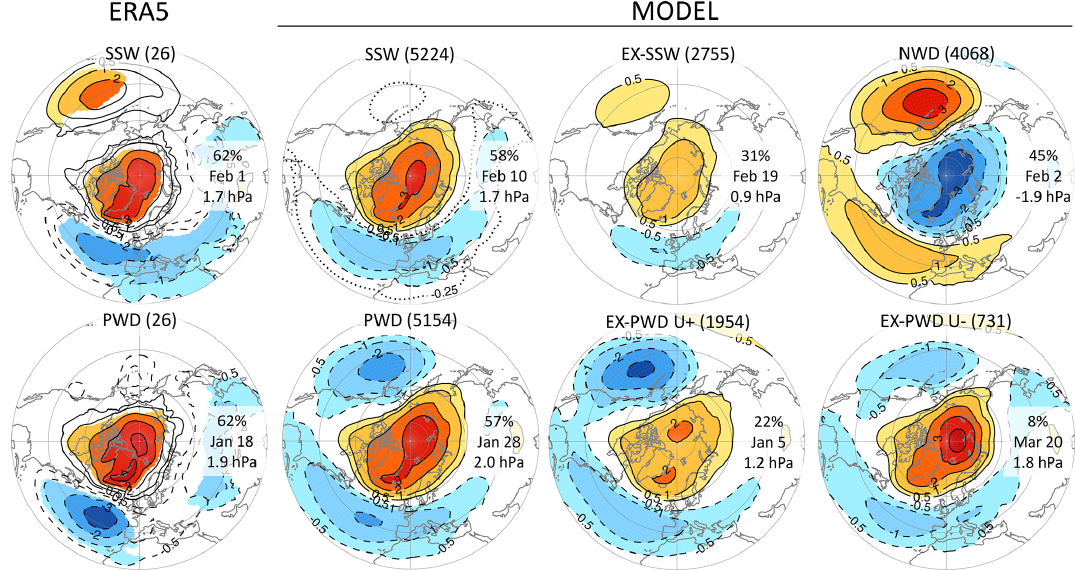
Figure 8. SLP response to stratospheric events. Shown are composite SLP anomalies (hPa), averaged from day 0 to 59 after event onset. The left column is for ERA5, and the remaining columns are for the model. Shadings indicate anomalies that are statistically significant according to a two-sided t test at the 5% error level. Contours are at ± 0 . 5, ± 1, ± 2, ± 3, and ± 4hPa; the extra dotted contour at − 0 . 25hPa is only shown for model-simulated SSWs. Annotations in each map indicate (i) absolute frequency, (ii) mean onset date, and (iii) slp wave driving threshold (cid:80) F (cid:48) is 12.9d for the model and 12.3d for ERA5. EX-PWD are PWDs that are not SSWs, and they are shown Z crit separately for U + ( u min > 0) and U − ( u min <